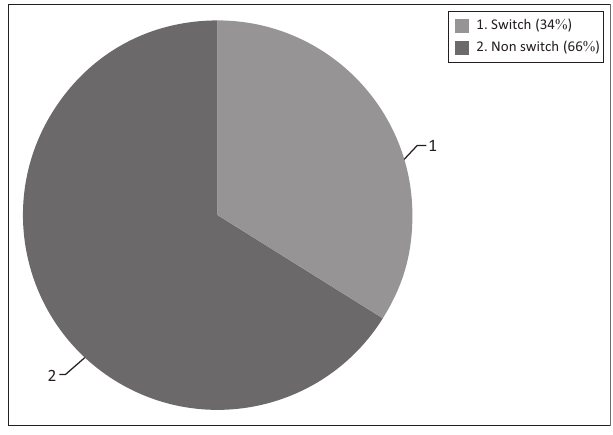
FIGURE 2: Percentage of patients who remained on FGA and percentage of patients who were switched to SGA.